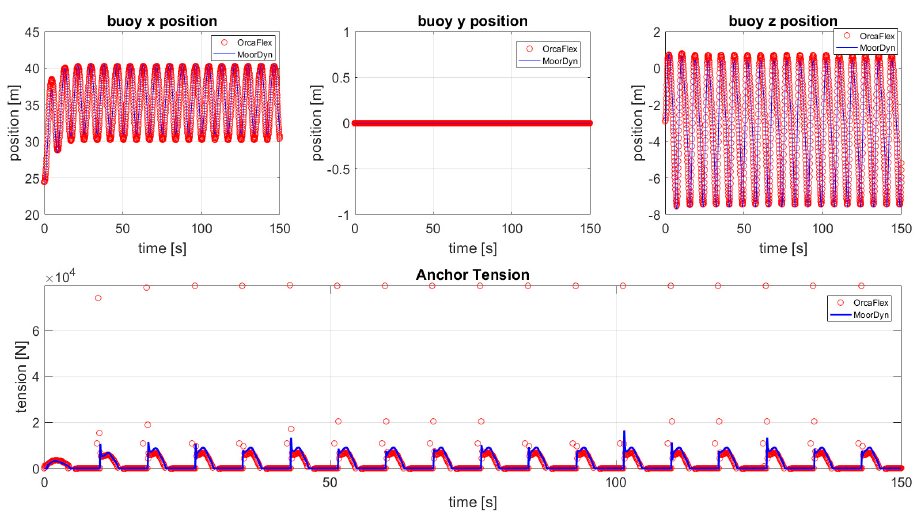
Figure 6. Simulation case 1: Time series of buoy’s position and tension at the anchor.